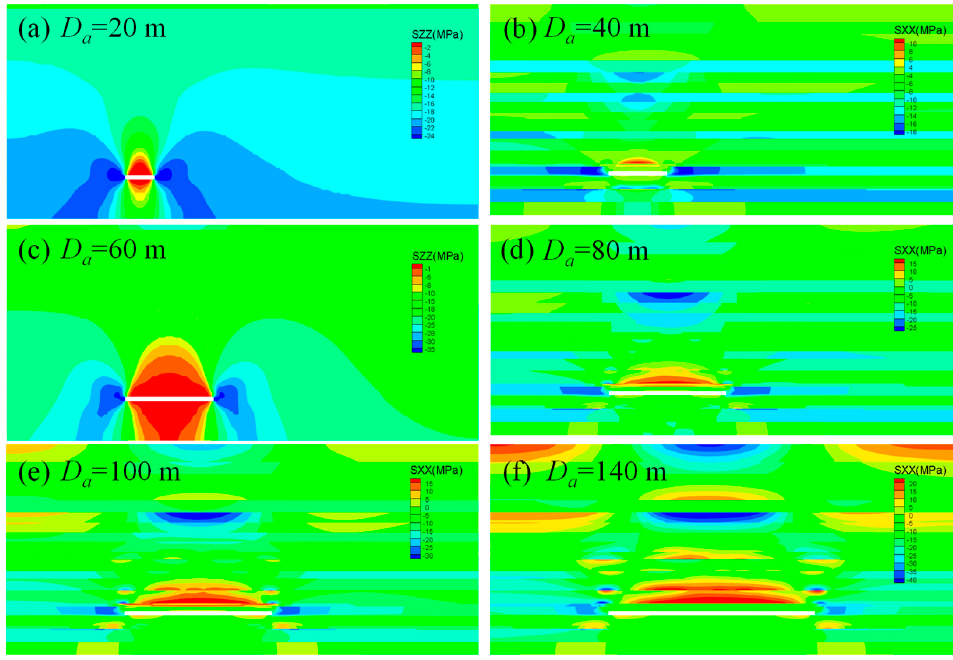
Figure 5. Horizontal stress evolution as the working face advances from 20 m to 140 m.